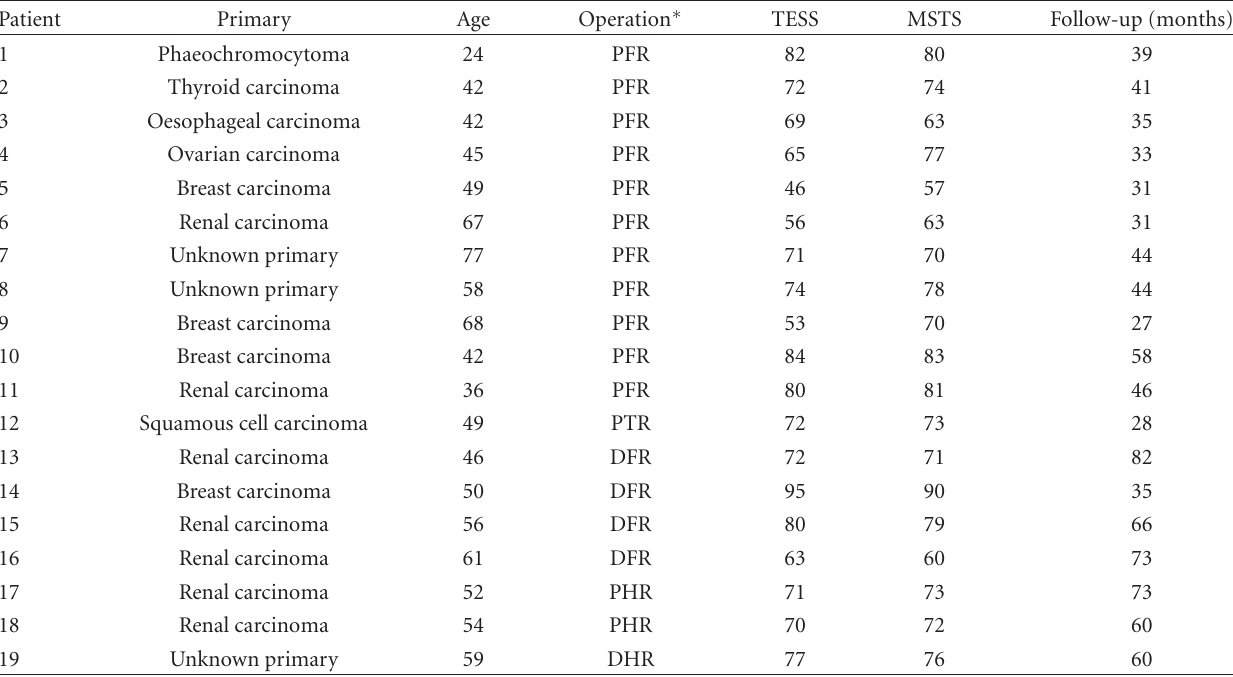
Table 3: Functional outcomes of the 19 patients (out of 58) surviving 2 years or